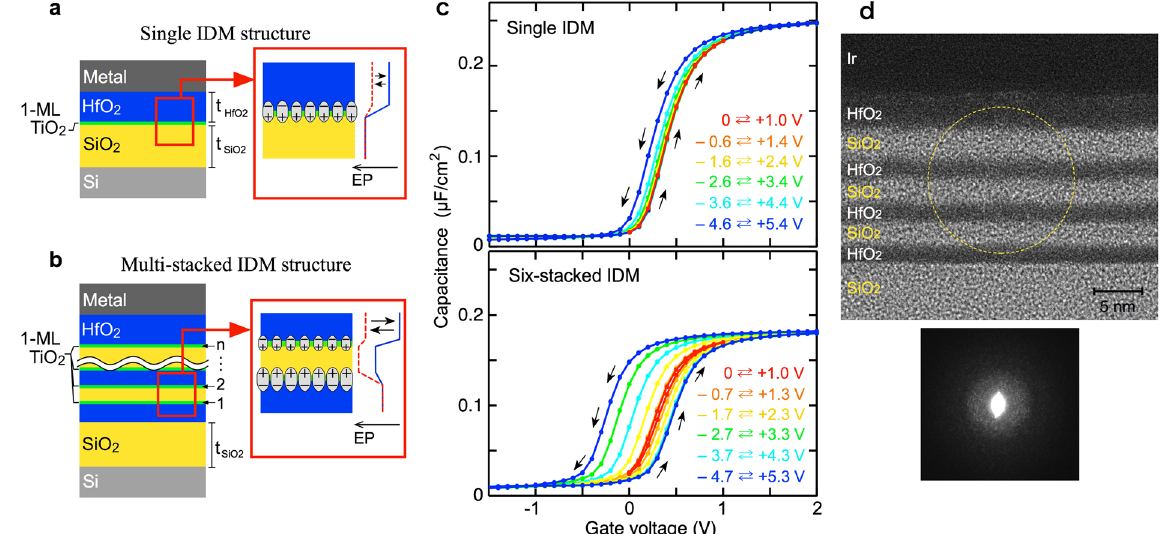
Figure 2. HfO 2 /SiO 2 -based IDM structures and C-V hysteresis curves. ( a and b) Schematic illustration of single and multi-stacked HfO 2 /1-ML TiO 2 /SiO 2 MOS structures. According to the IDM mechanism, the modulation by the TiO 2 modulators at two facing interfaces are superimposed and enhanced. ( c ) C-V curves observed from single and six-stacked IDM MOS capacitors fabricated on n-type Si substrates. The former consists of 3-nm- thick top HfO 2 and 10-nm-thick bottom SiO 2 layer, while the latter consists of 3.5-nm-thick top HfO 2 , 1.8-nm- thick inner SiO 2 , 1.8-nm-thick inner HfO 2 , and 10-nm-thick bottom SiO 2 layers. Small counterclockwise hysteresis appears in a single IDM structure and an obviously large hysteresis appears in the six-stacked IDM structure. ( d ) Transmission electron microscopy (TEM) image and electron diffraction (ED) pattern of the six-stacked IDM structure. These results indicate that all oxide layers are amorphous. Note that it is difficult to distinguish between SiO 2 and TiO 2 in the TEM